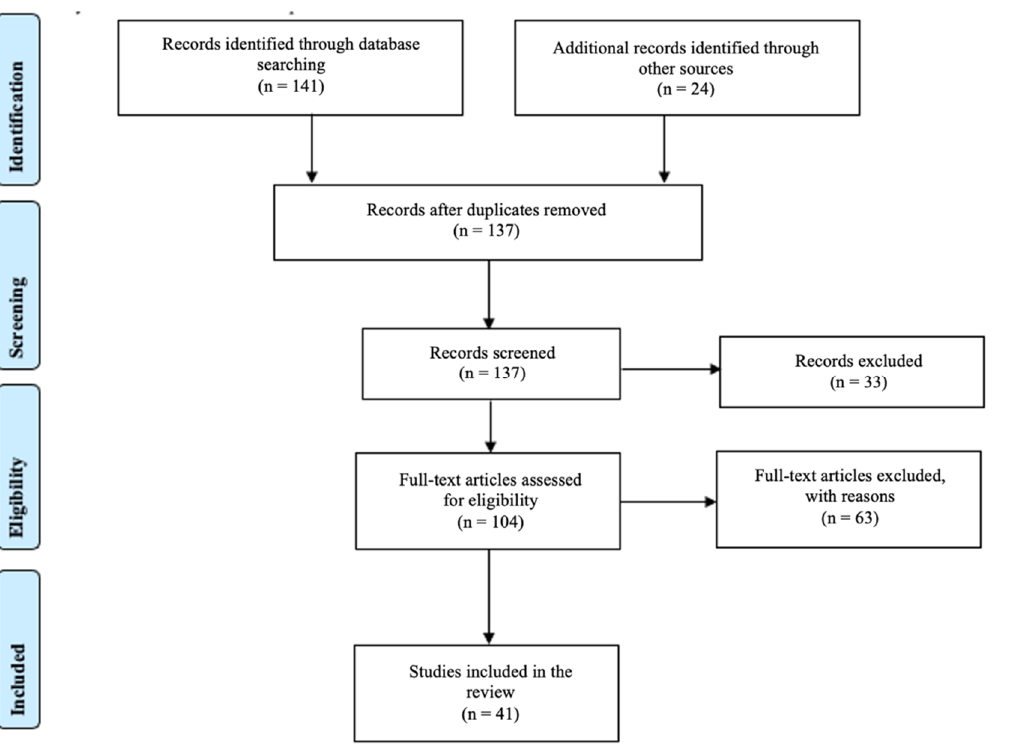
Figure 3. Systematic literature review